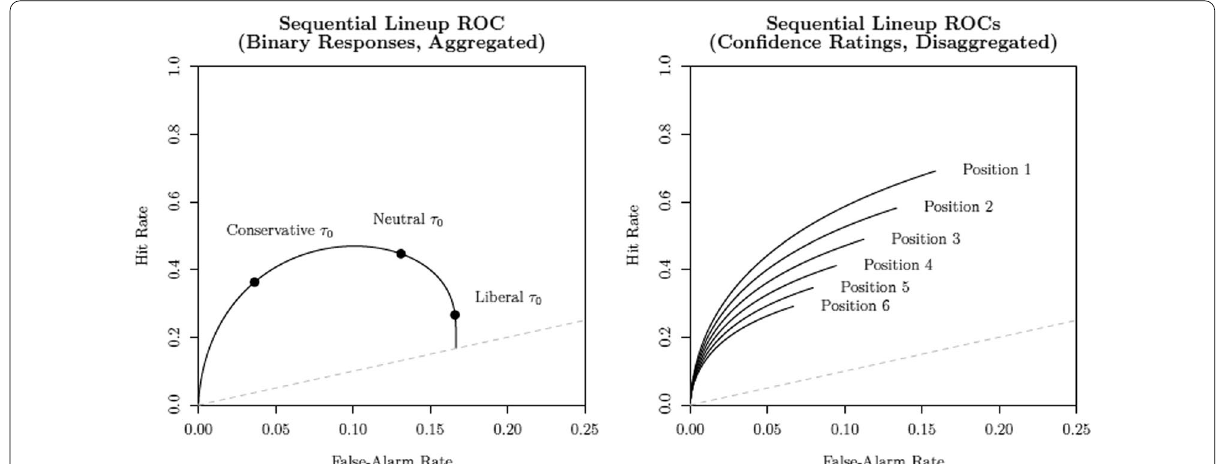
Fig. 3 Example of ROCs obtained in a sequential lineup procedure. Left panel: The predicted ROC function when varying response criterion τ 0 and aggregating across sequence positions. Right panel: Confidence rating ROCs obtained for each sequence